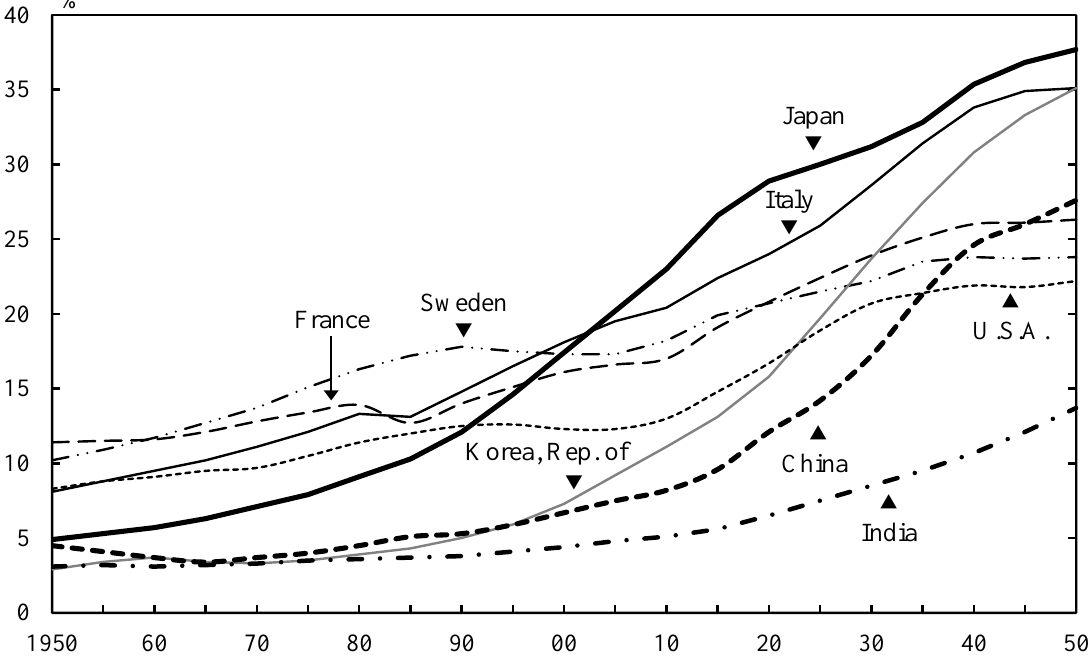
Figure 2.5 Proportion of Elderly Population by Country (Aged 65 years and over)